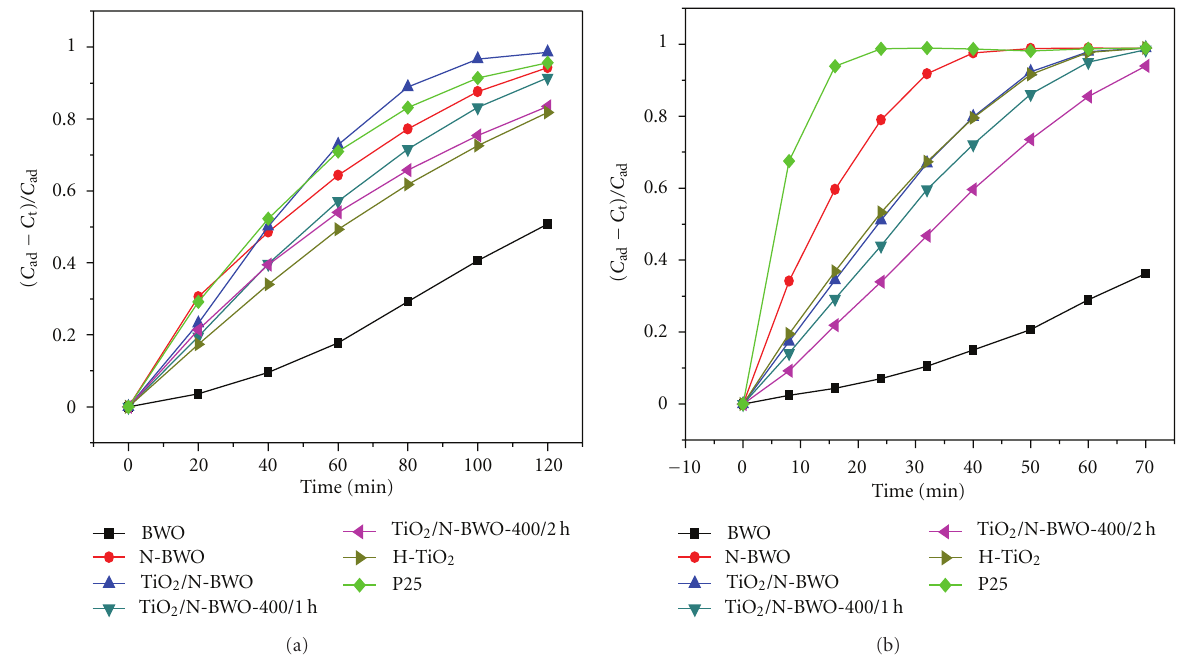
Figure 6: Photocatalytic activity for decomposition of rhodamine B (4 × 10 − 5 mol L − 1 ) under (a) visible light ( > 420nm) and (b) ultraviolet light ( < 400nm) irradiation at room temperature in air over the as-prepared catalysts. C ad : the concentration of RhB after dark adsorption, C t : the concentration of RhB during the photocatalytic